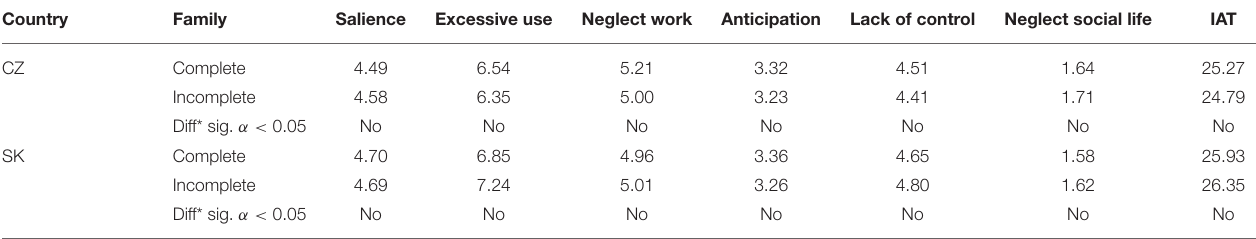
TABLE 6 | Mean values of the IAT and its subscales in the classification by family. Country Family Salience Excessive use Neglect work Anticipation CZ